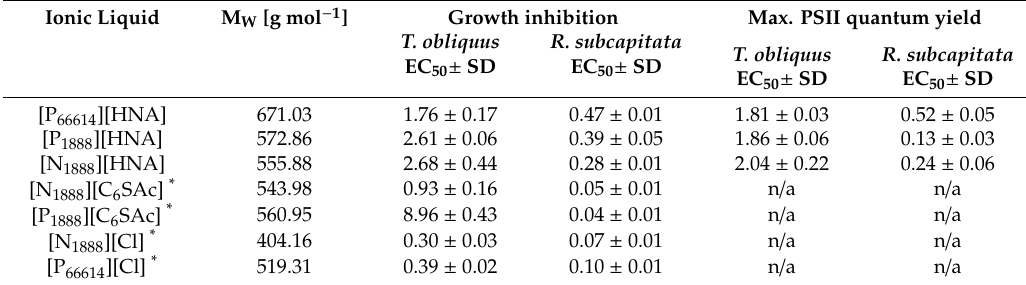
Table 4. Influence of the ILs on growth and chlorophyll fluorescence after 72 h (EC 50 values ± SD) in acute toxicity